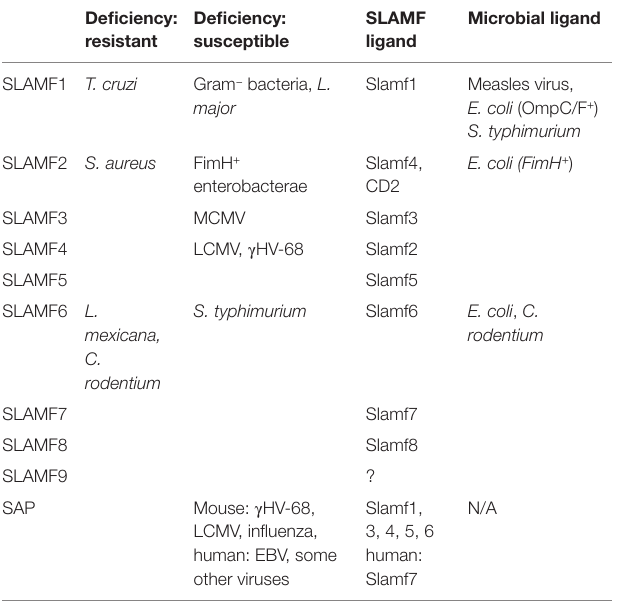
TABLe 2 | Slamf receptors and their adaptor SAP modulate susceptibility to